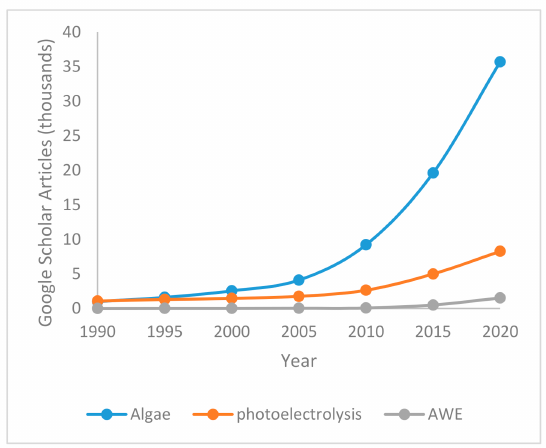
Figure 1. Cumulative growth in Google Scholar articles published